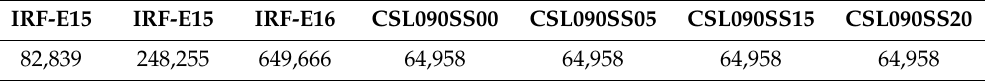
Figure 5. Geometry of the 8.4 mm thick test specimen. (units are in mm).